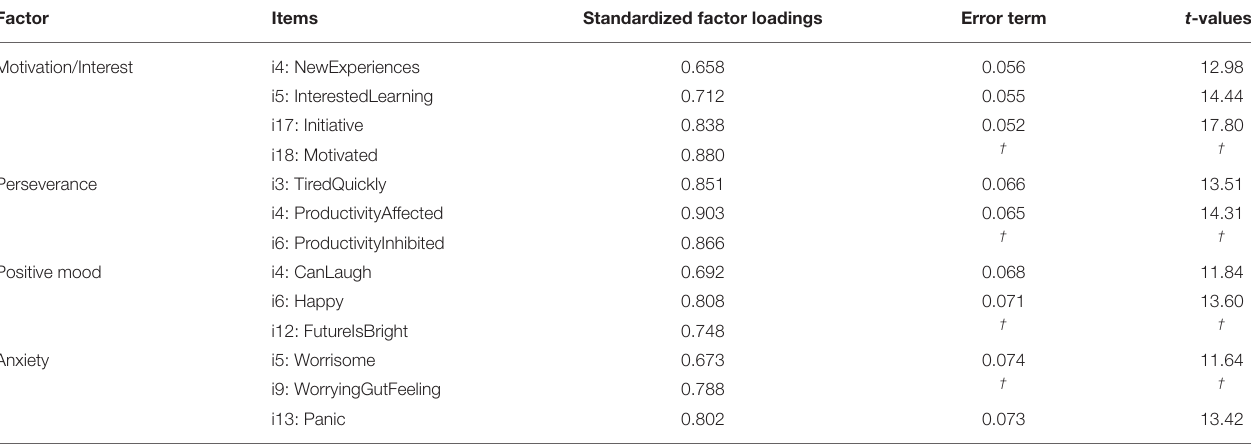
TABLE 3 | Parameter estimates, error terms, and t -values for the four-factor model. Factor